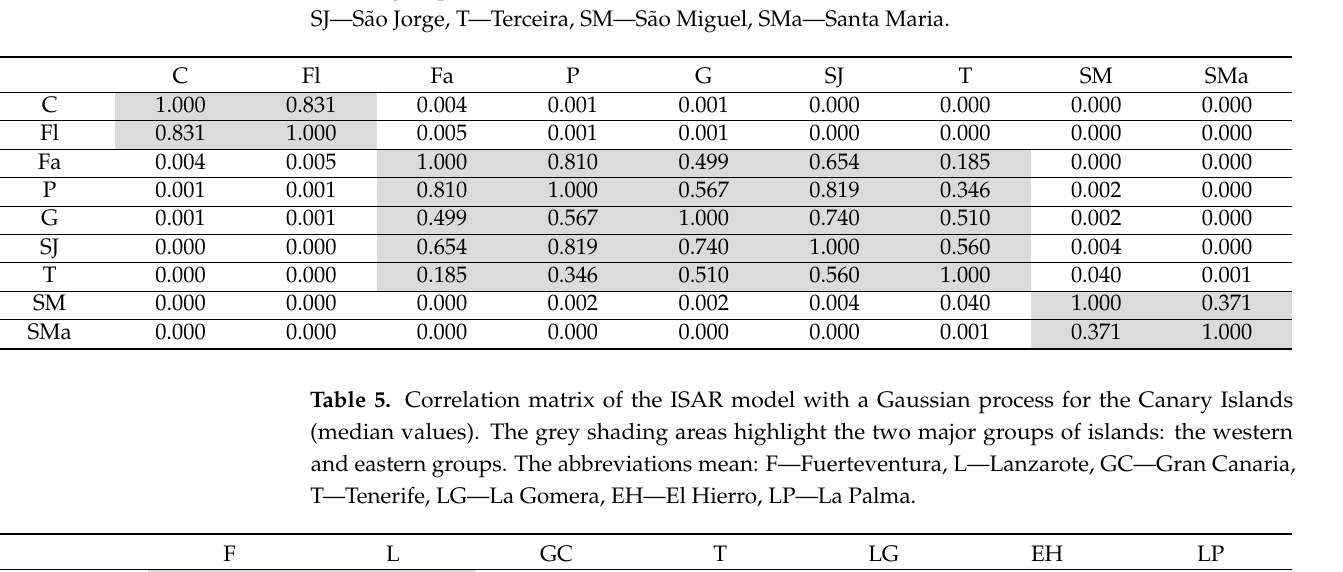
Table 4. Correlation matrix of the ISAR model with a Gaussian process for the Azores (median values). The grey shading areas highlight the three major groups of islands: the western, central, and eastern groups. The abbreviations mean: C—Corvo, Fl—Flores, Fa—Faial, P—Pico, G—Graciosa,